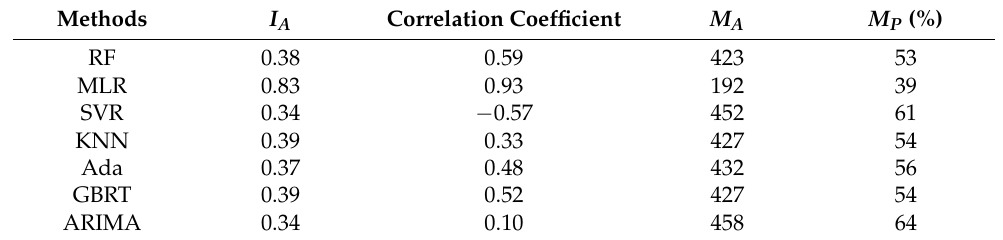
Table 5. I A , correlation coefficient, M A , and M P of all methods for predicting PM 10 in dust